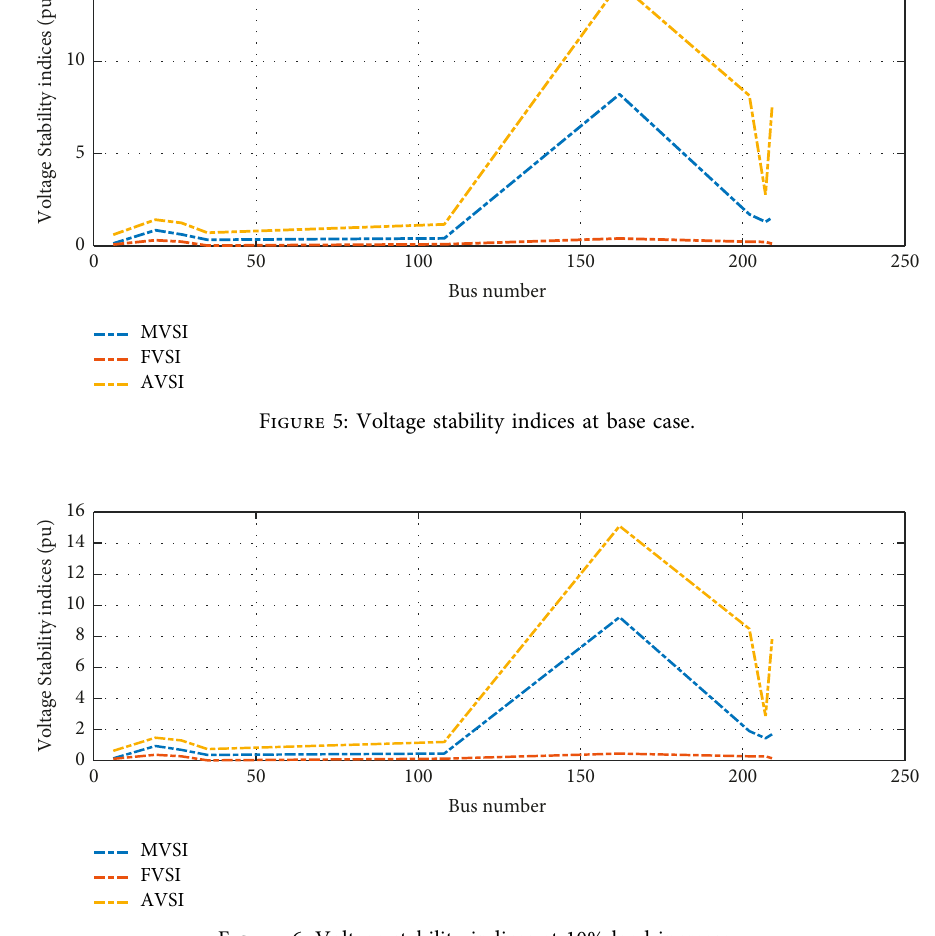
Figure 6: Voltage stability indices at 10% load increase. Table 3: Values of stability indices at 20% and 30% load increasing